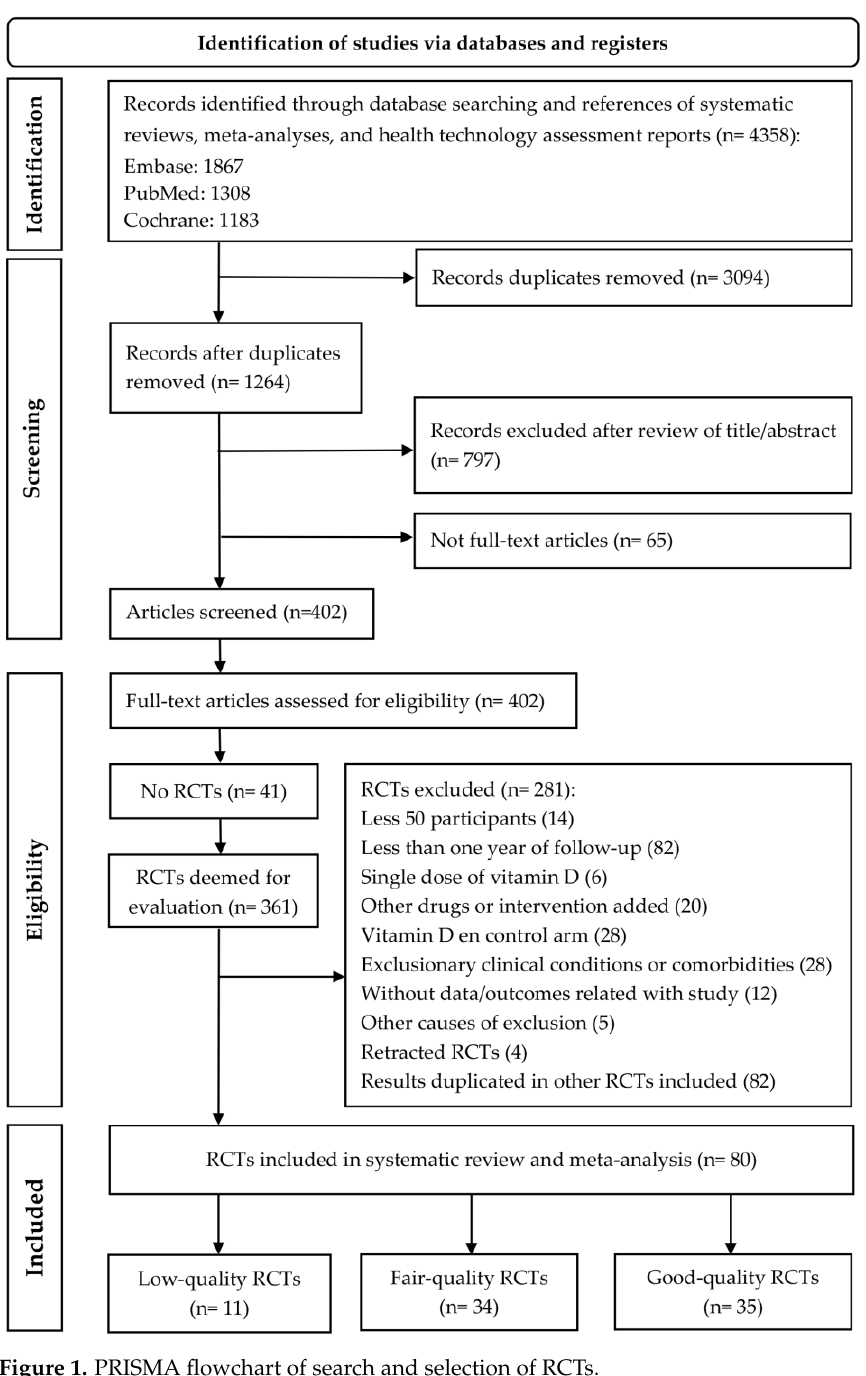
Figure 1. PRISMA flowchart of search and selection of RCTs.